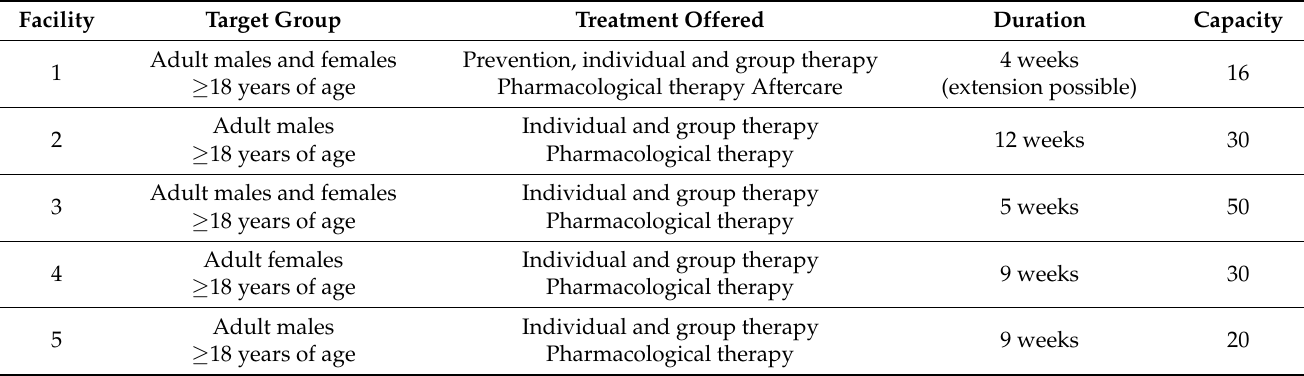
Table 1. Core features of participating treatment